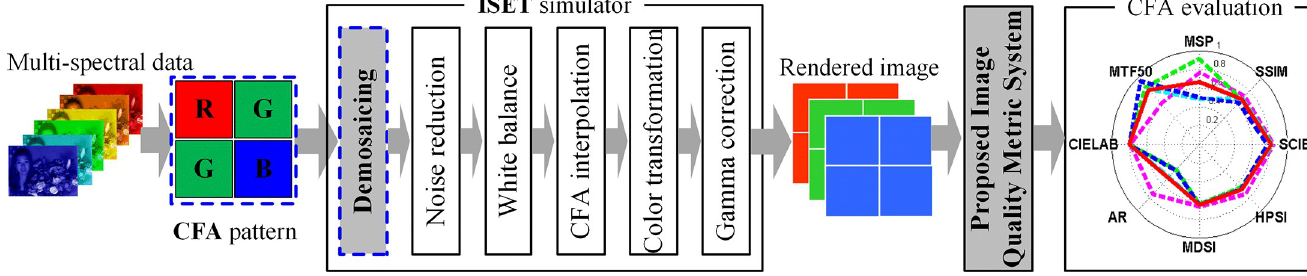
Fig 2. Proposed CFA IQ evaluation